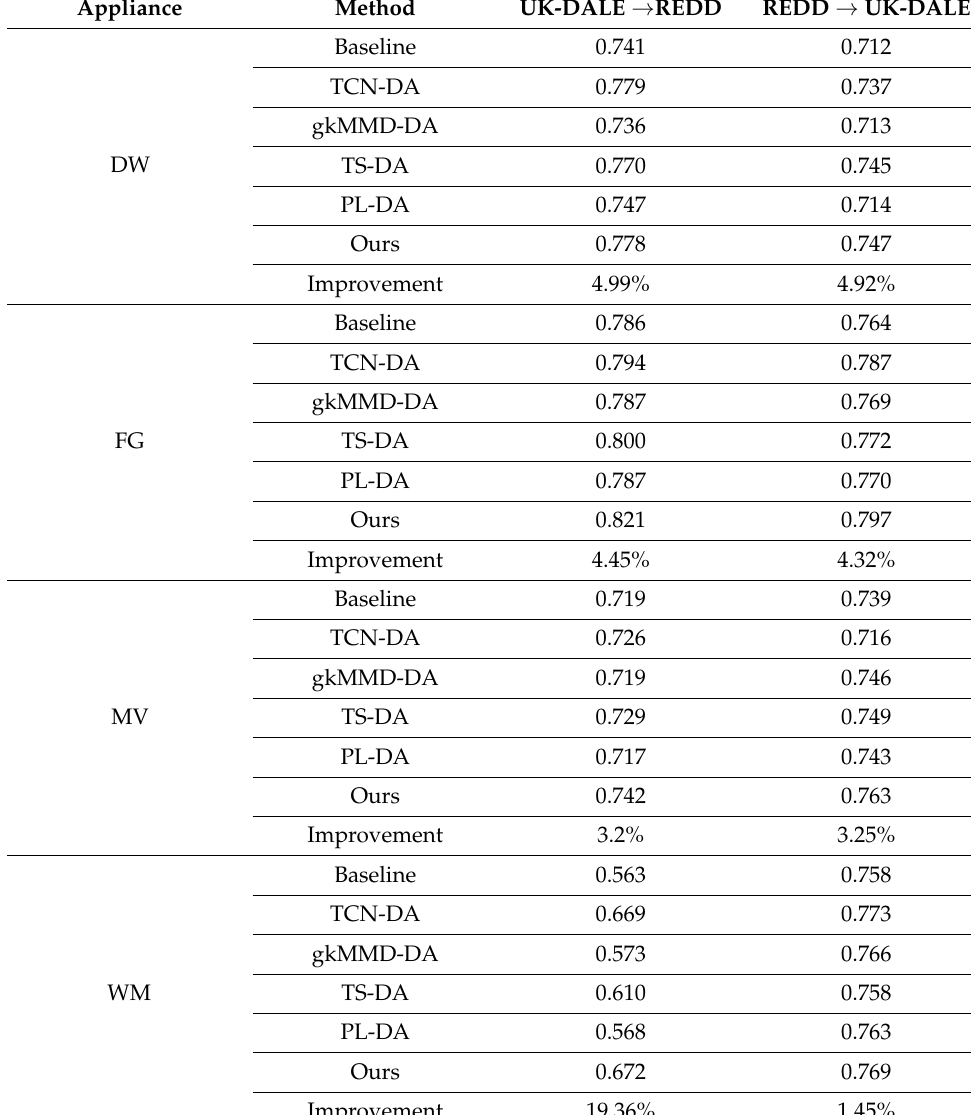
Table 5. F1 score comparison of domain adaptation between different